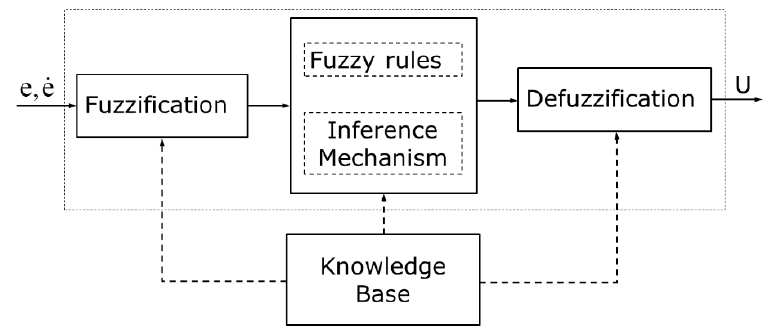
Figure 12. The general structure of a fuzzy controller of a bipedal robot.